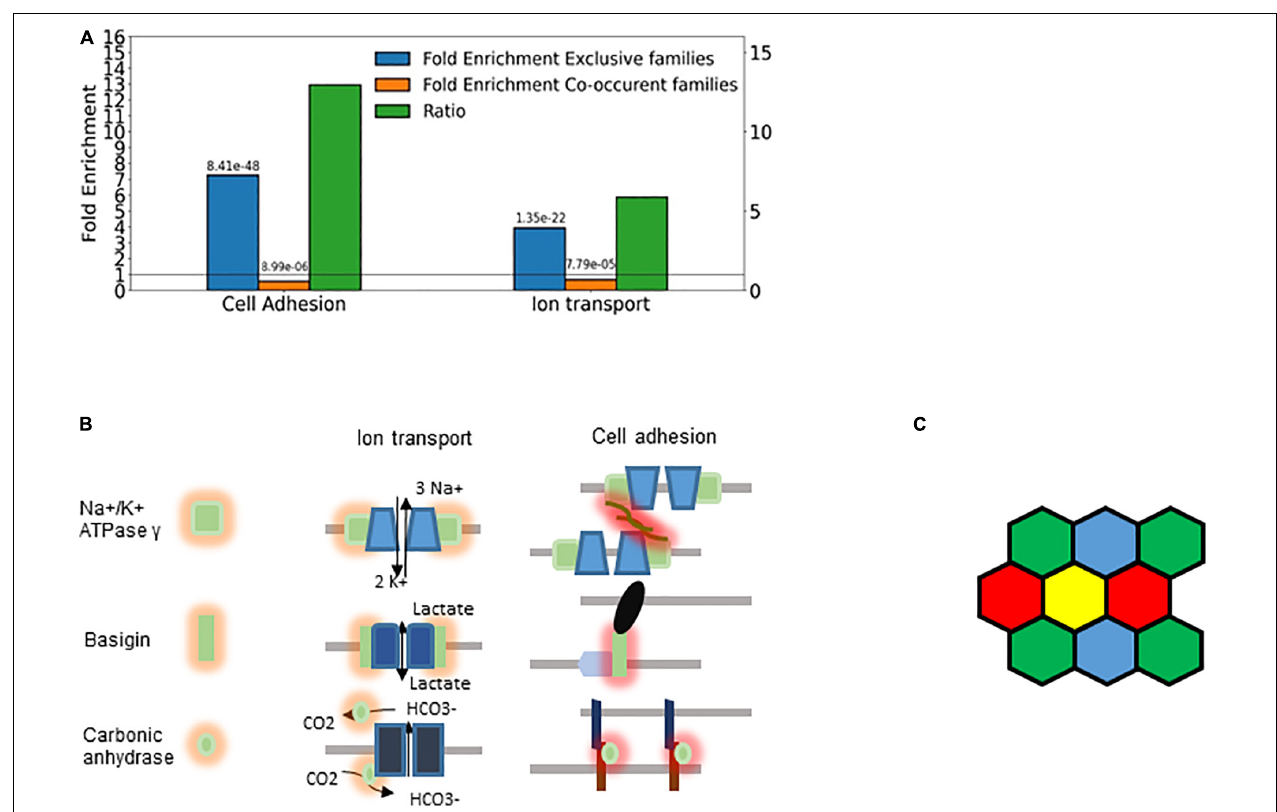
FIGURE 8 | Cellular individuality and cell adhesion. (A) Enrichment analysis of the genes belonging to exclusive and concurrent gene families. The P -values are indicated on the top of the bars. The exclusive families were selected with the criteria described in Figures 4B , 7 . The concurrent families (IC belonging to top 2.5 percentile) were constrained with the following criteria: mean number of expressed genes per cell higher than 0.03, IC significantly higher than 1 and at least 5 non-zero genes per family. We considered all the genes expressed at least in one cell type belonging to the selected families. The enrichment analysis was performed though an enrichment analysis tool (http://geneontology.org/). The figure shows two selected functions: Cell adhesion (GO: 0007155) and Ion transport (GO: 0006811). The ratio of the fold-enrichment in the exclusive to that in concurrent families is shown. (B) Schematic representation highlighting the dual role of three gene families (Fxyd, basigin, and carbonic anhydrase genes). On the left side, the cis interaction of the corresponding proteins with channels and pumps is denoted by orange shades. These functions are related to metabolic and ion homeostasis. On the right side, the trans-interaction with ligands on the adjacent cells is labeled with red shades. The glycosylation of the Fxyd protein affects the transdimerization of the Na + /K + ATPase. The carbonic anhydrase interacts with the anion exchange protein, which transports HCO 3 - . (C) Schematic representation of cells showing that the exclusive expression of four gene isoforms (colors) is sufficient to confer cellular individuality in a two dimensional